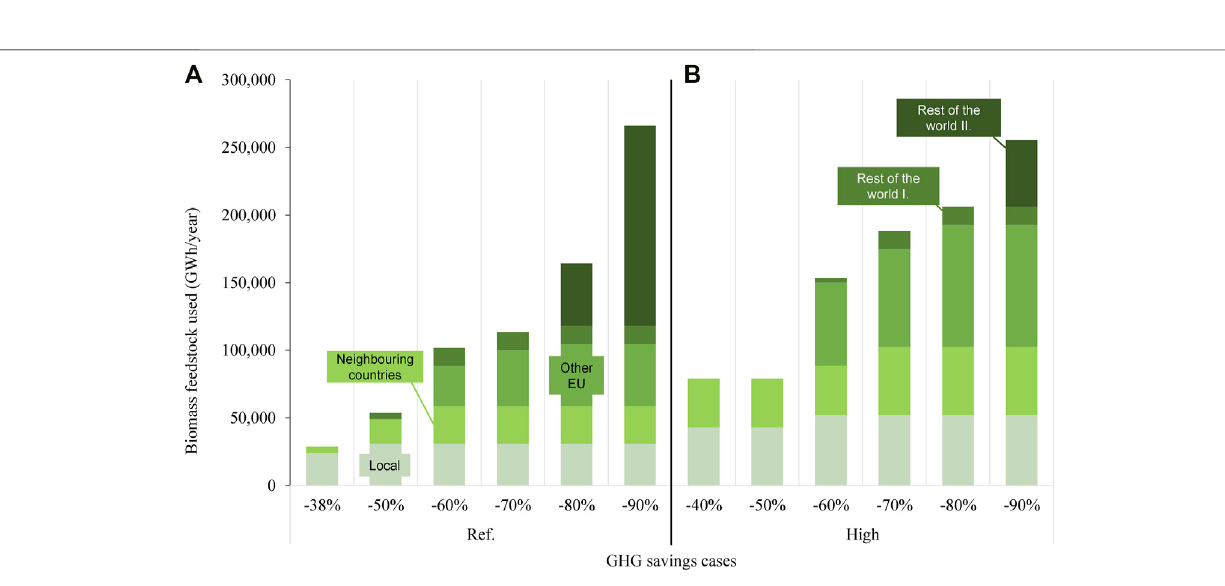
Frontiers in Energy Research |